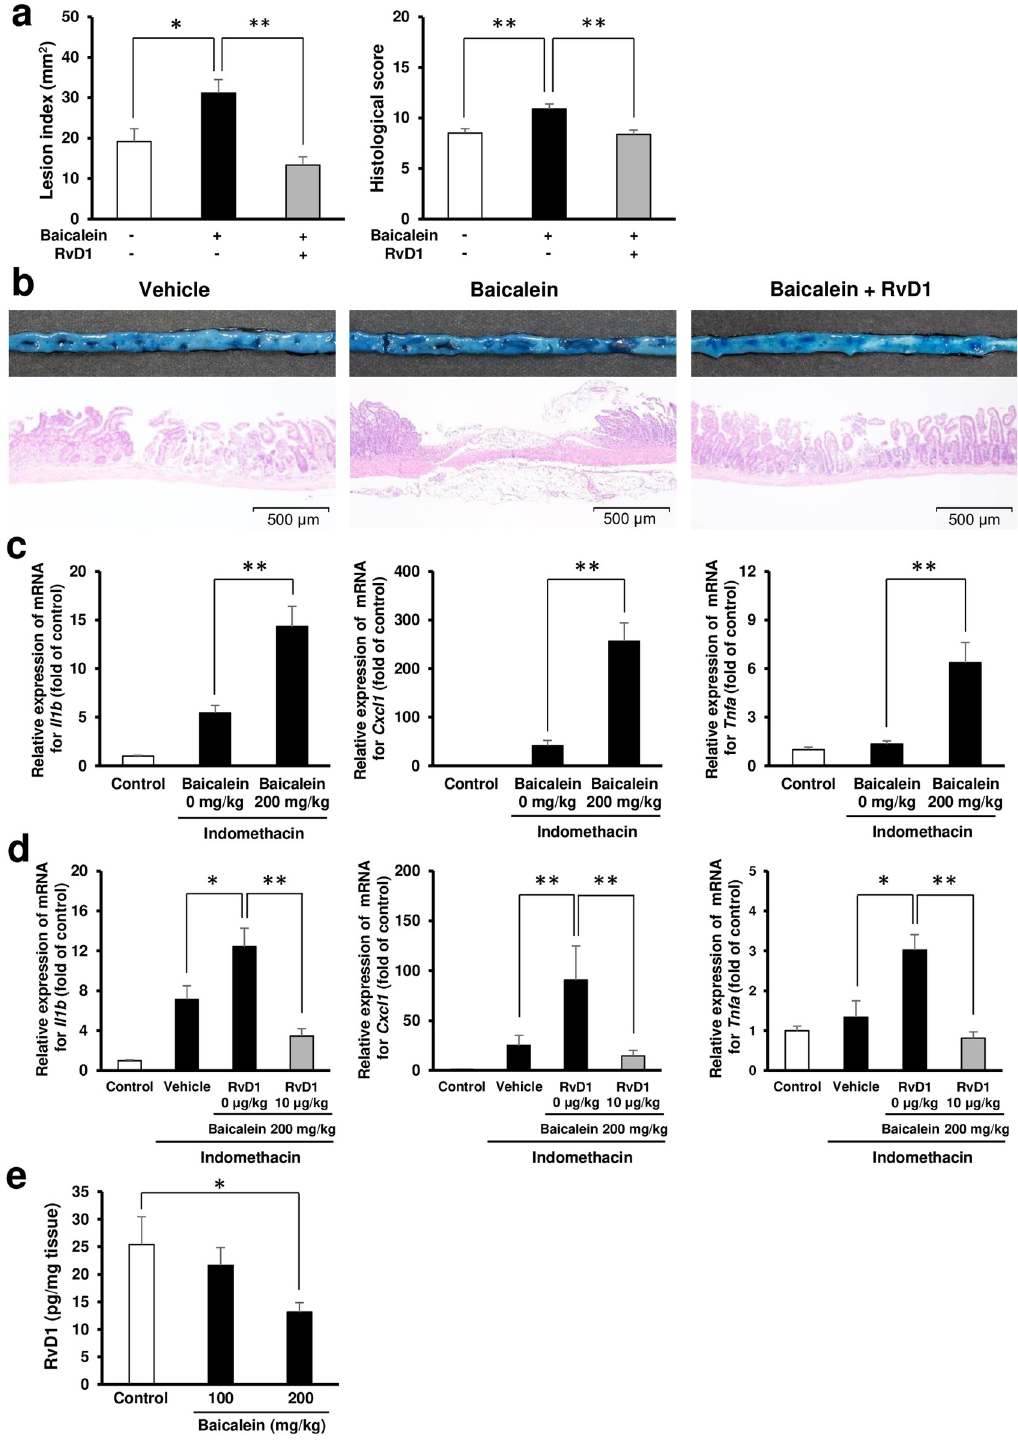
Fig 3. Effect of inhibition of activity of 12/15-lipoxygenase on indomethacin-induced small intestinal damage. (a) The effect of baicalein, a 12/15-lipoxygenase inhibitor, on indomethacin-induced small intestinal damage. Lesion index and histological score of the group pre-administered with baicalein and the group pre-administered baicalein (200 mg/kg BW) and resolvin D1 (RvD1: 10 μ g/kg BW). N = 7–8. Baicalein and resolvin D1 were administered 3 and 24 h before administration of indomethacin. (b) Representative macroscopic and microscopic images of small intestine 24 h after administration of